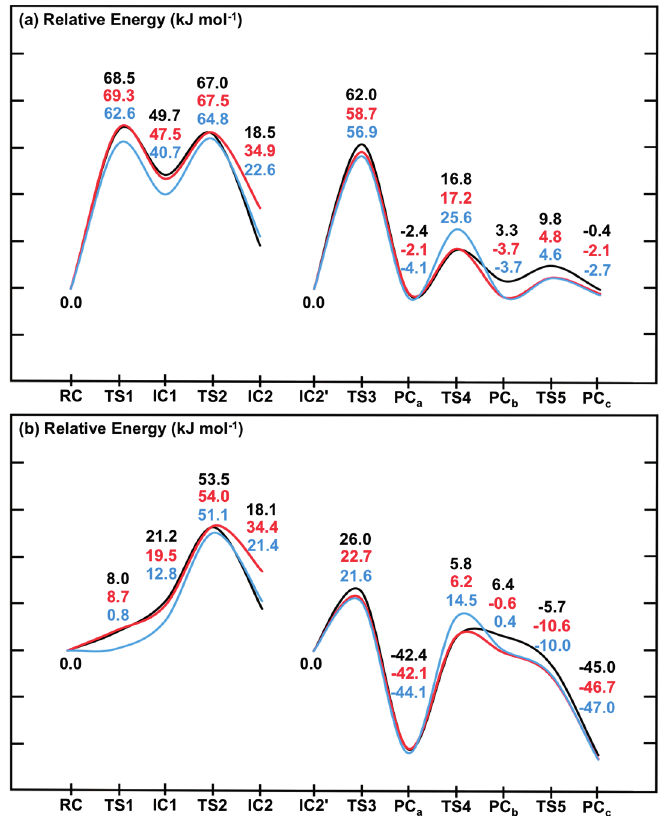
Figure 7. Potential energy surfaces for the overall catalytic mechanism of SpNic obtained at the ONIOM( DFT /6-311+G(2df,p):AMBER96)//ONIOM(B3LYP/6-31G(d):AMBER96) level i of theory within the ( a ) ME and ( b ) EE formalism. DFT or M06